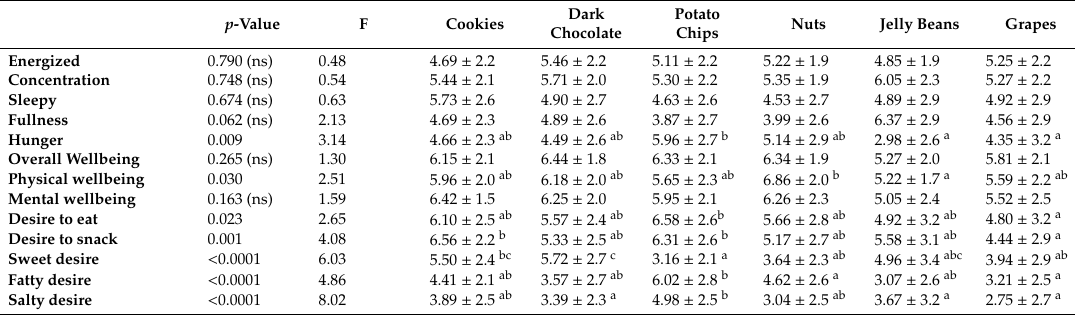
Table 4. Least squares means ± standard deviations ( n = 253) from analysis of variance (ANOVA). p -Value F Cookies Dark Chocolate Potato Chips Nuts Jelly Beans Grapes